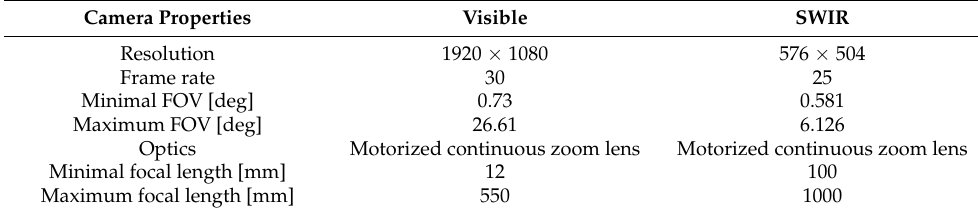
Table 2. Visible-light and SWIR camera properties.